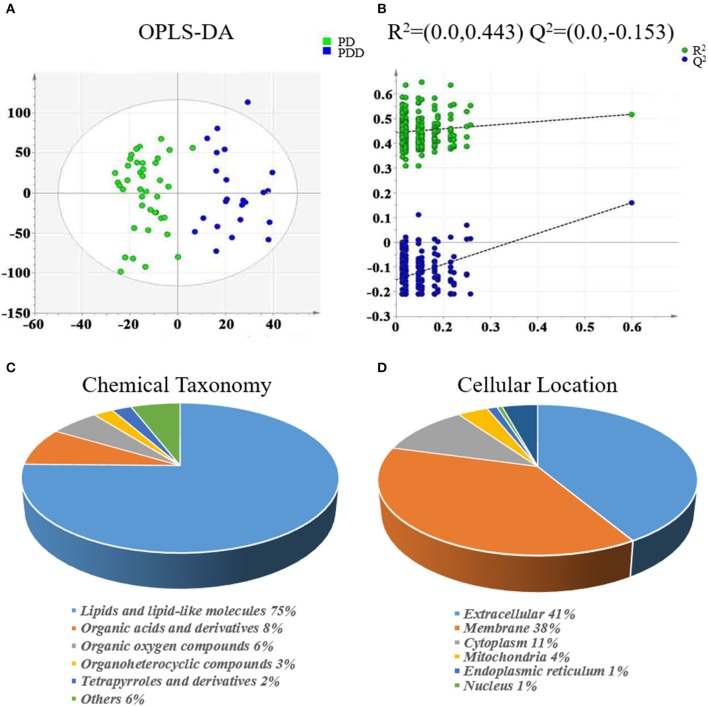
Multivariate statistical analysis of metabolomics and classification of differentially expressed metabolites between patients with PDD and PD. (A) OPLS-DA score plot derived from liquid chromatography-mass spectrometry-based metabolomics analysis of patients with PDD (blue circles) and patients with PD (green circles). (B) Statistical validation of the OPLS-DA model by permutation testing. Representations of metabolites in terms of (C) chemical taxonomy and (D) cellular locations, based on the annotations of Human Metabolome Database. OPLS-DA, orthogonal partial least squares-discriminant analysis; PDD, Parkinson's disease-related depression; PD, Parkinson's disease.